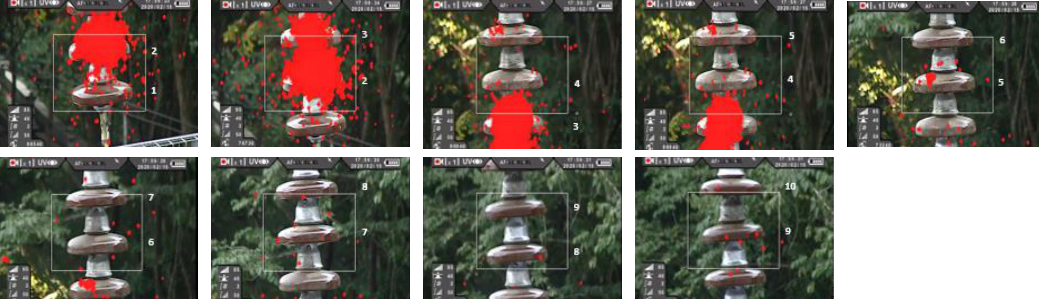
Figure 2. UV connection between the cup-and-pin insulators that had reached 40% of string length. The first cup-and-pin insulator was closest to the energized terminal.